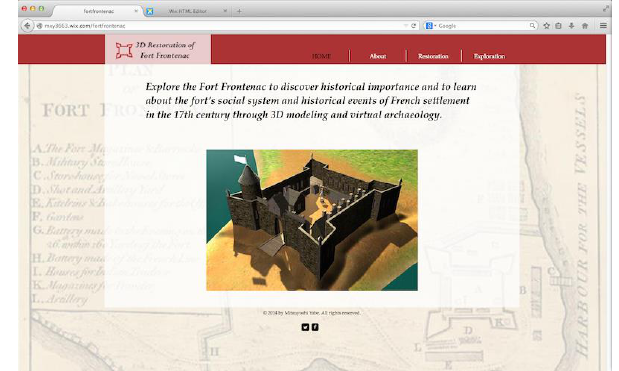
Figure 10: The website of the 3D restoration of Fort Frontenac.